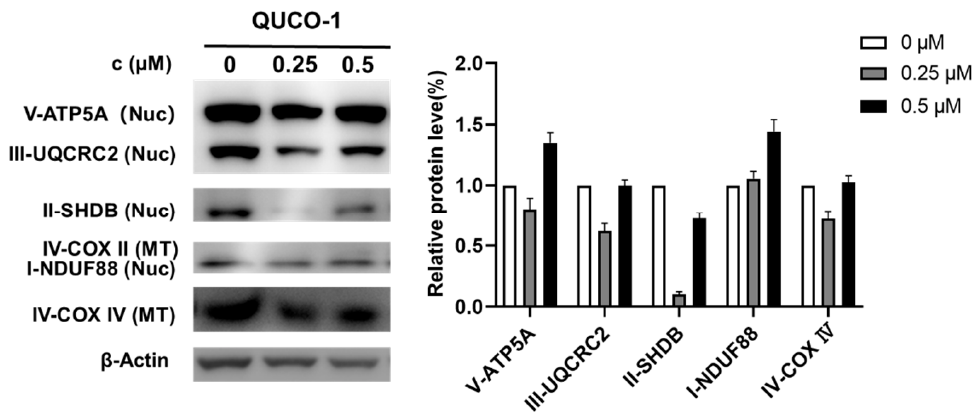
Figure 5. Western blotting analysis of mitochondrial complex upon 48 h treatment of QUCO-1 in RKO cells.